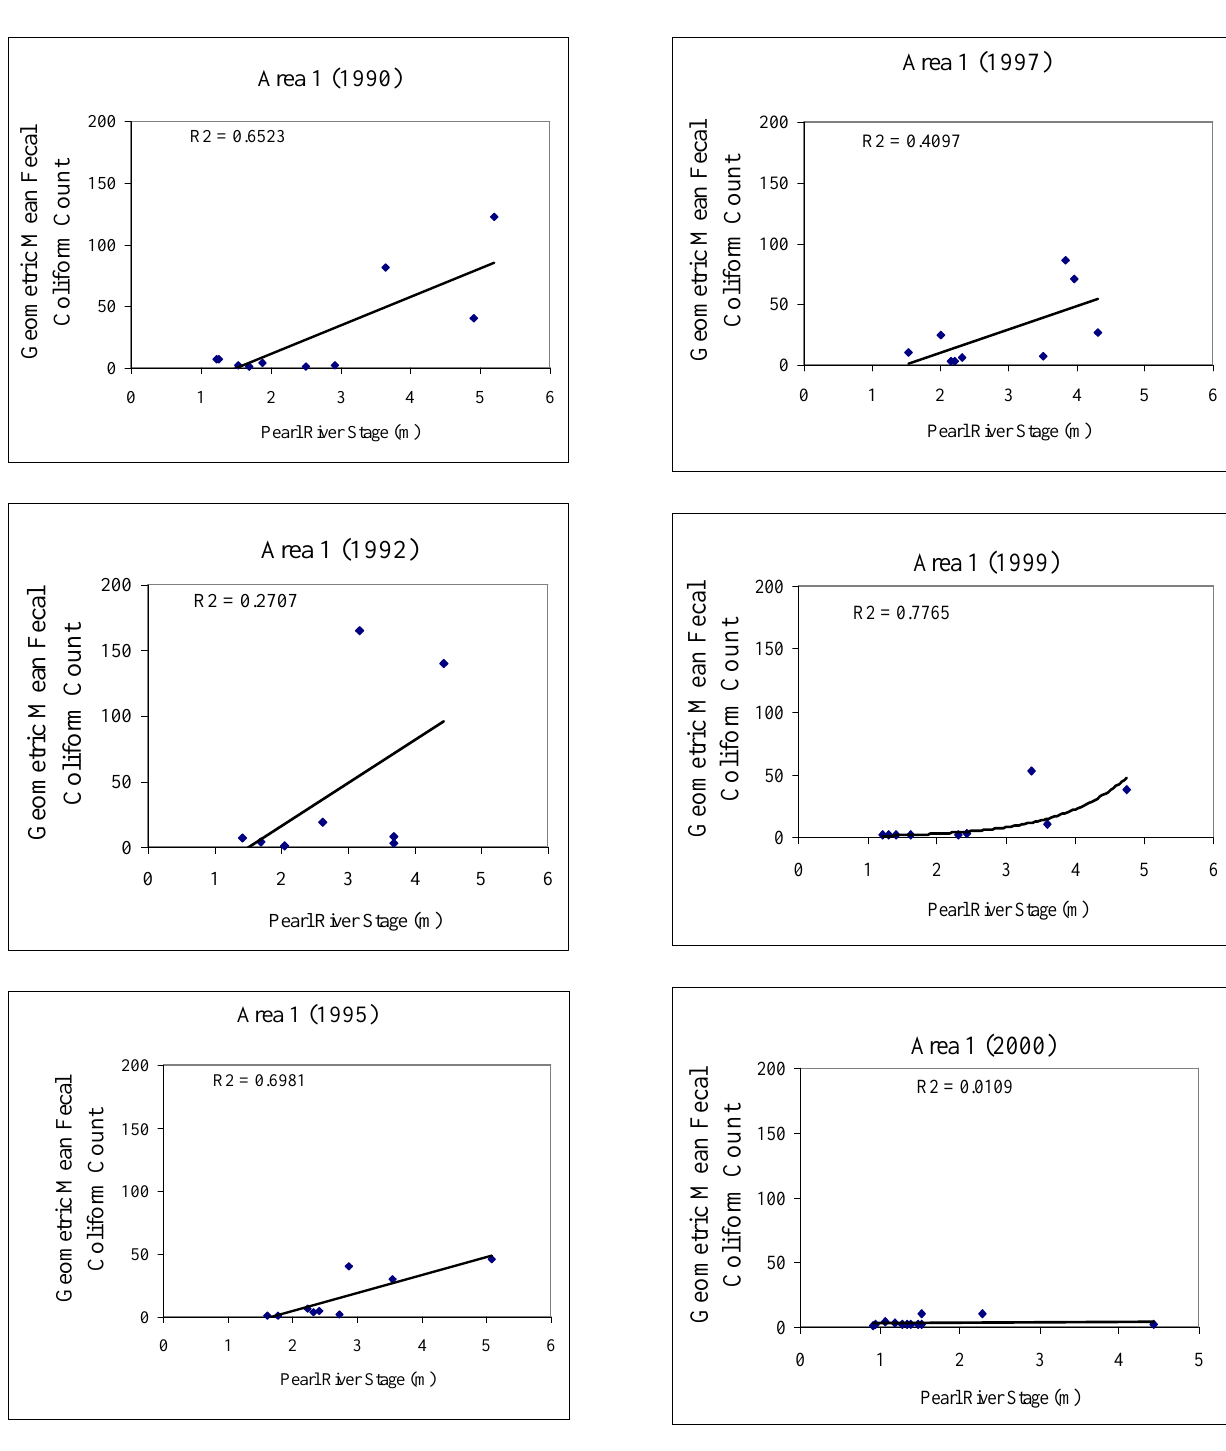
Figure 4: Relationship between the geometric mean fecal coliform count and Pearl River stage for various